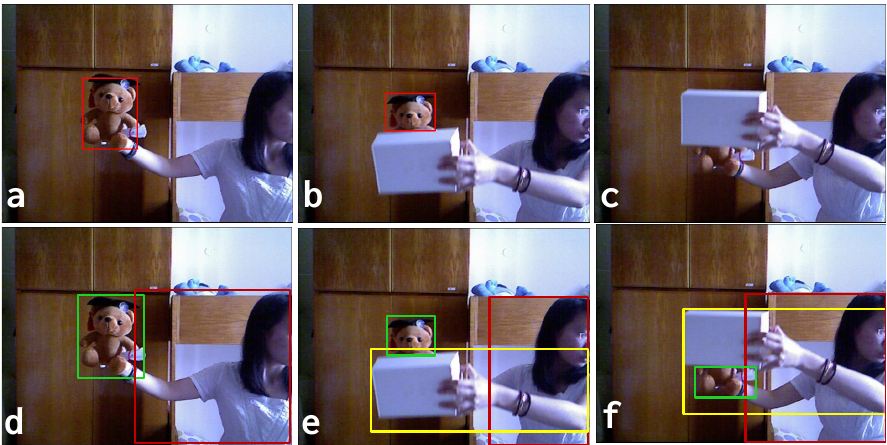
Figure 1. Three snapshots (non-consecutive) were taken from the PTB [1] data set, where ( a – c ) show the ground truth of the object (here, the toy bear) tracking marked by red bounding boxes, and ( d – f ) show the probable result of any obstacle(s) detection (marked by red, yellow, and green boxes)